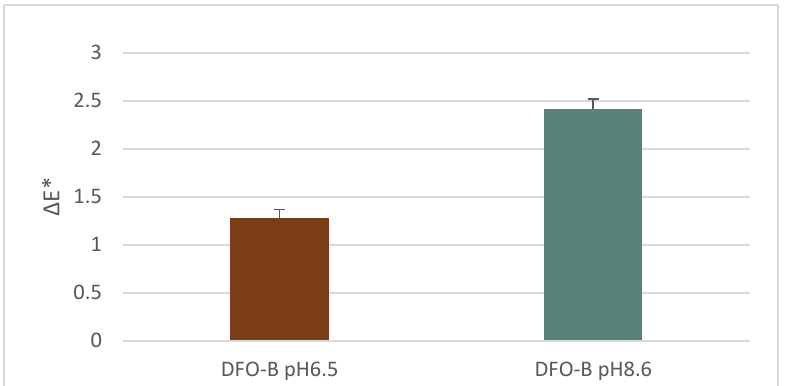
Figure 10. ΔE* of the controls after the 8 th application of DFO- B hydrogels at pH 6.5 and 8.6. All ΔE* Figure 10. ∆ E* of the controls after the 8th application of DFO-B hydrogels at pH 6.5 and 8.6. All ∆ E* values are averages of four replicates. values are averages of four